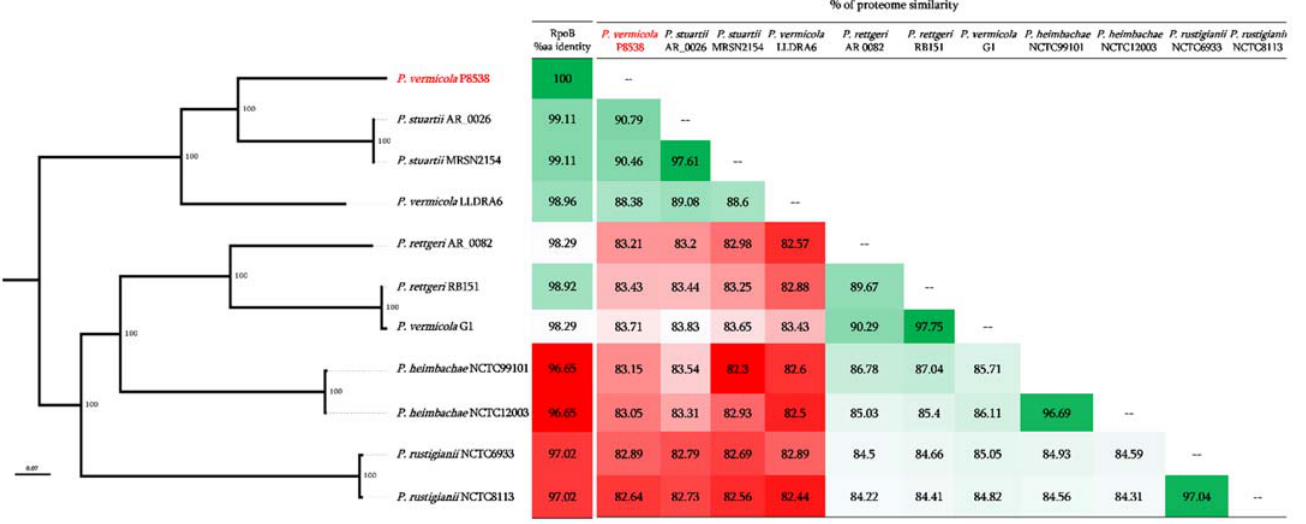
Figure 3. Proteome Pairwise comparison and the RpoB phylogenetic tree of Providencia genomes.